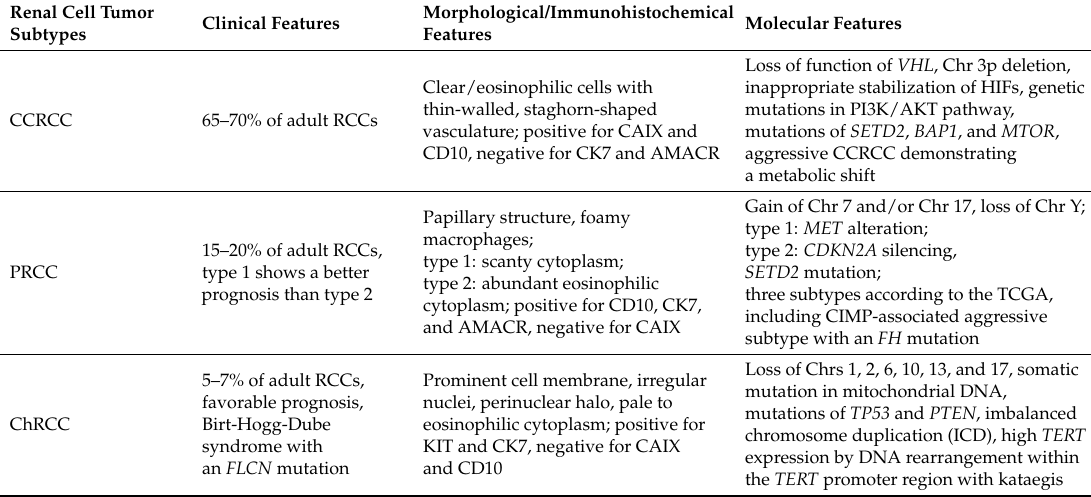
Table 2. Current major subtypes of renal cell tumors in the 2016 WHO classification [1]. Renal Cell Tumor